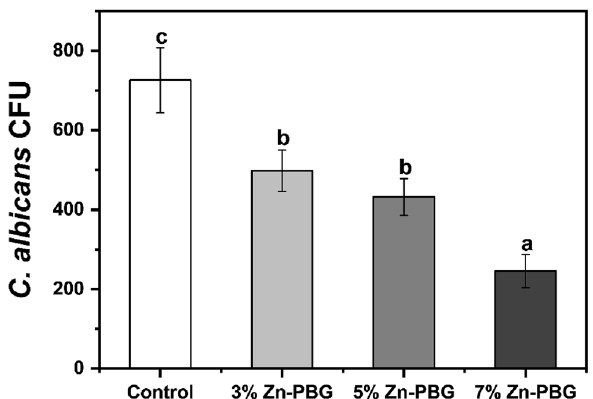
Figure 5. Colony-forming unit counts (CFU) of fungi on surfaces of various auto-polymerized acrylic resin samples: ( A ) control; (B ) 3% Zn-PBG; ( C ) 5% Zn-PBG; ( D ) 7% Zn-PBG. Different lowercase letters above a bar indicate a significant difference at p < 0.05.